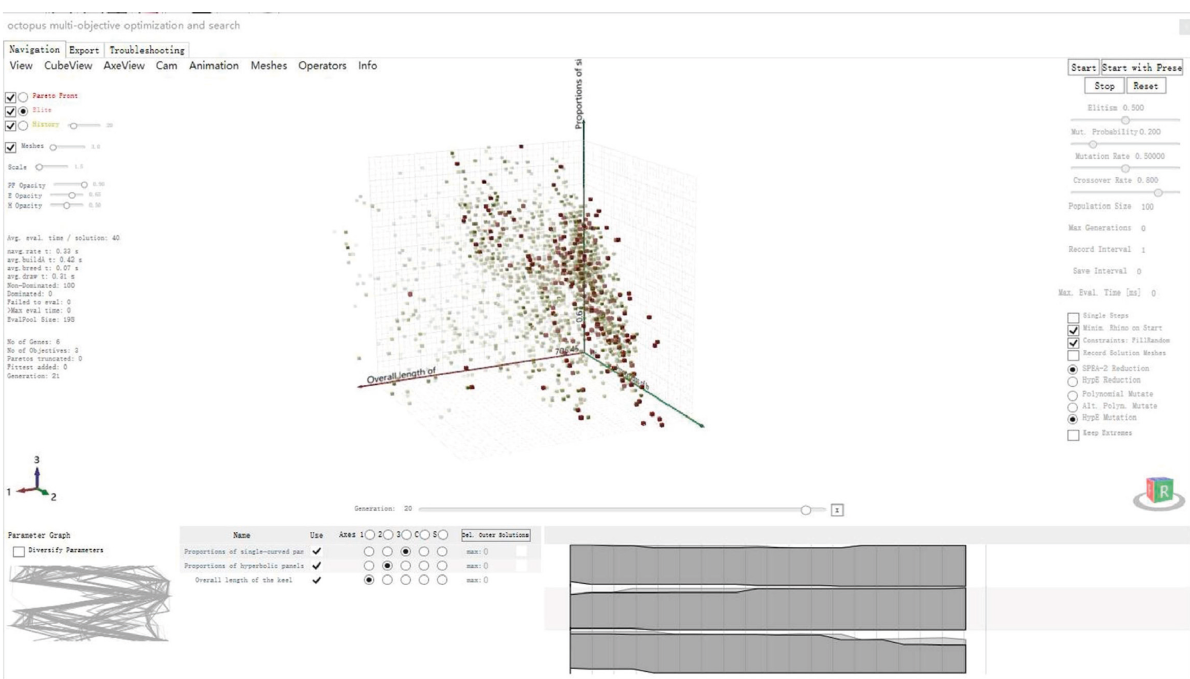
Figure 9: “Octopus” component